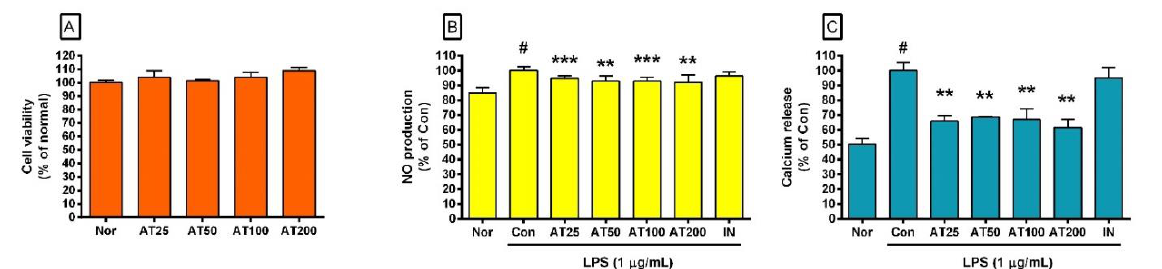
Figure 1. Effects of Angelicae tenuissimae Radix (AT) water extract on cell viability ( A ), Nitric Oxide (NO) production ( B ), and Calcium release ( C ) in RAW 264.7. Values are presented as mean ± SD. Nor, the group treated with cell culture media alone; Con, the group treated with lipopolysaccharide (LPS, 1 µ g/mL) alone. AT25 means 25 µ g/mL of AT, AT50 means 50 µ g/mL of AT, AT100 means 100 µ g/mL of AT, and AT200 means 200 µ g/mL of AT. IN, indomethacin at 0.5 µ M. #, p < 0.05 vs. Nor; **, p < 0.01 vs. Con; ***, p < 0.001 vs. Con.